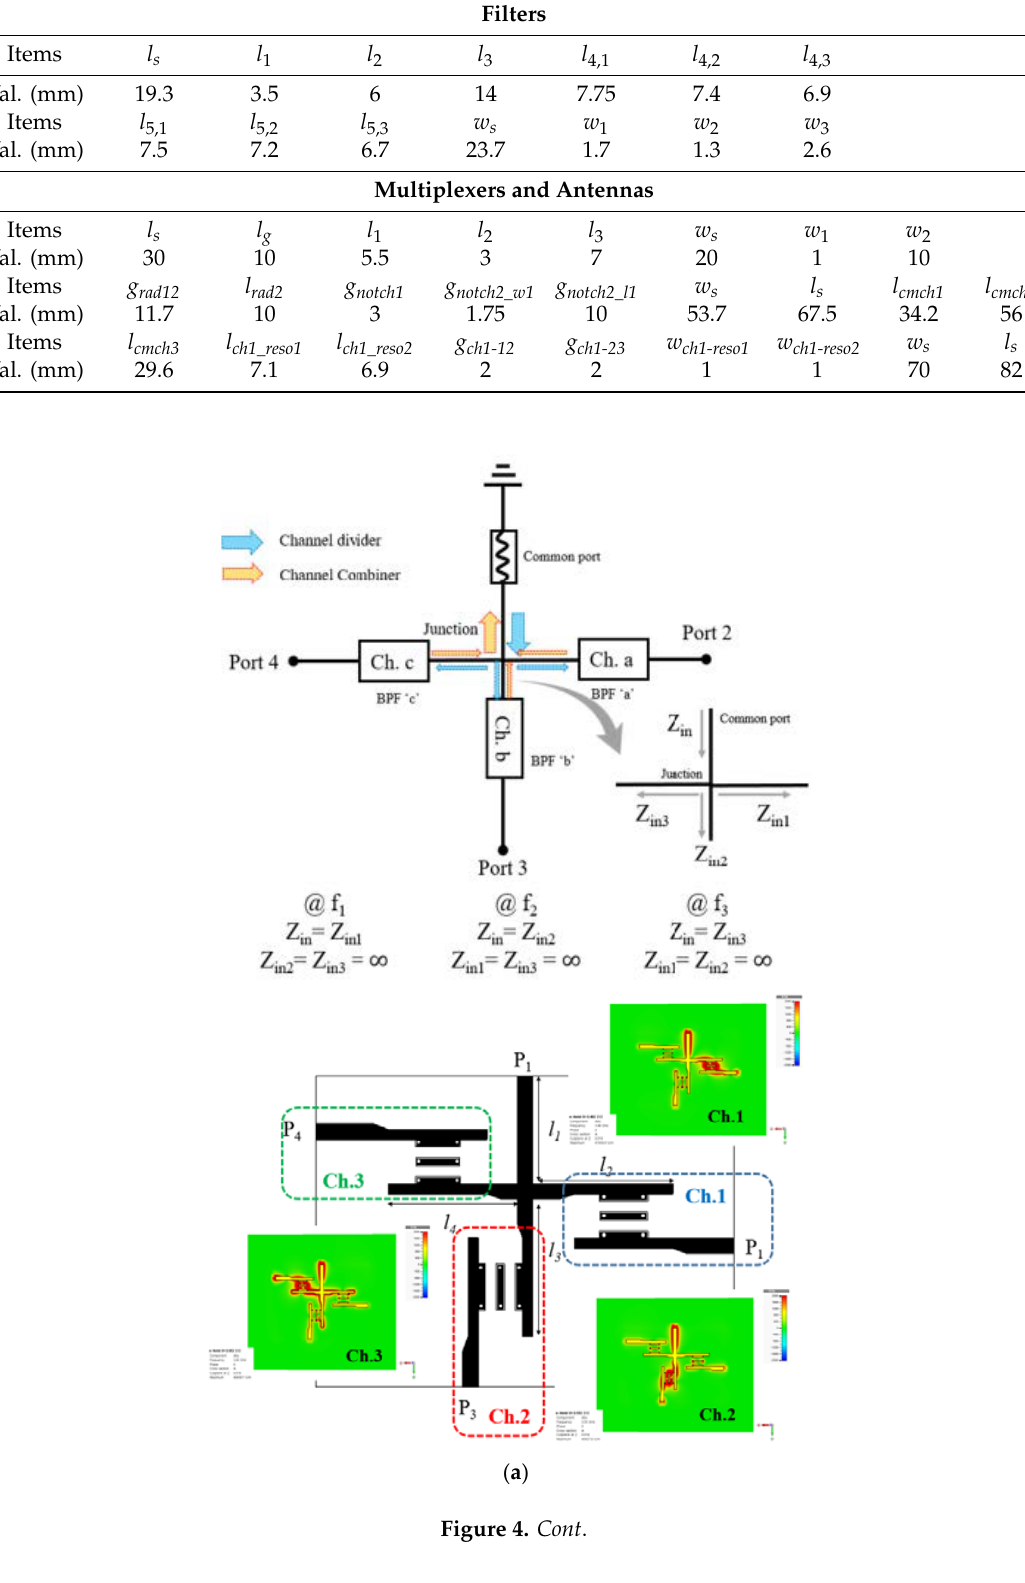
Table 1. Geometrical parameters of the filters, multiplexers and antennas.